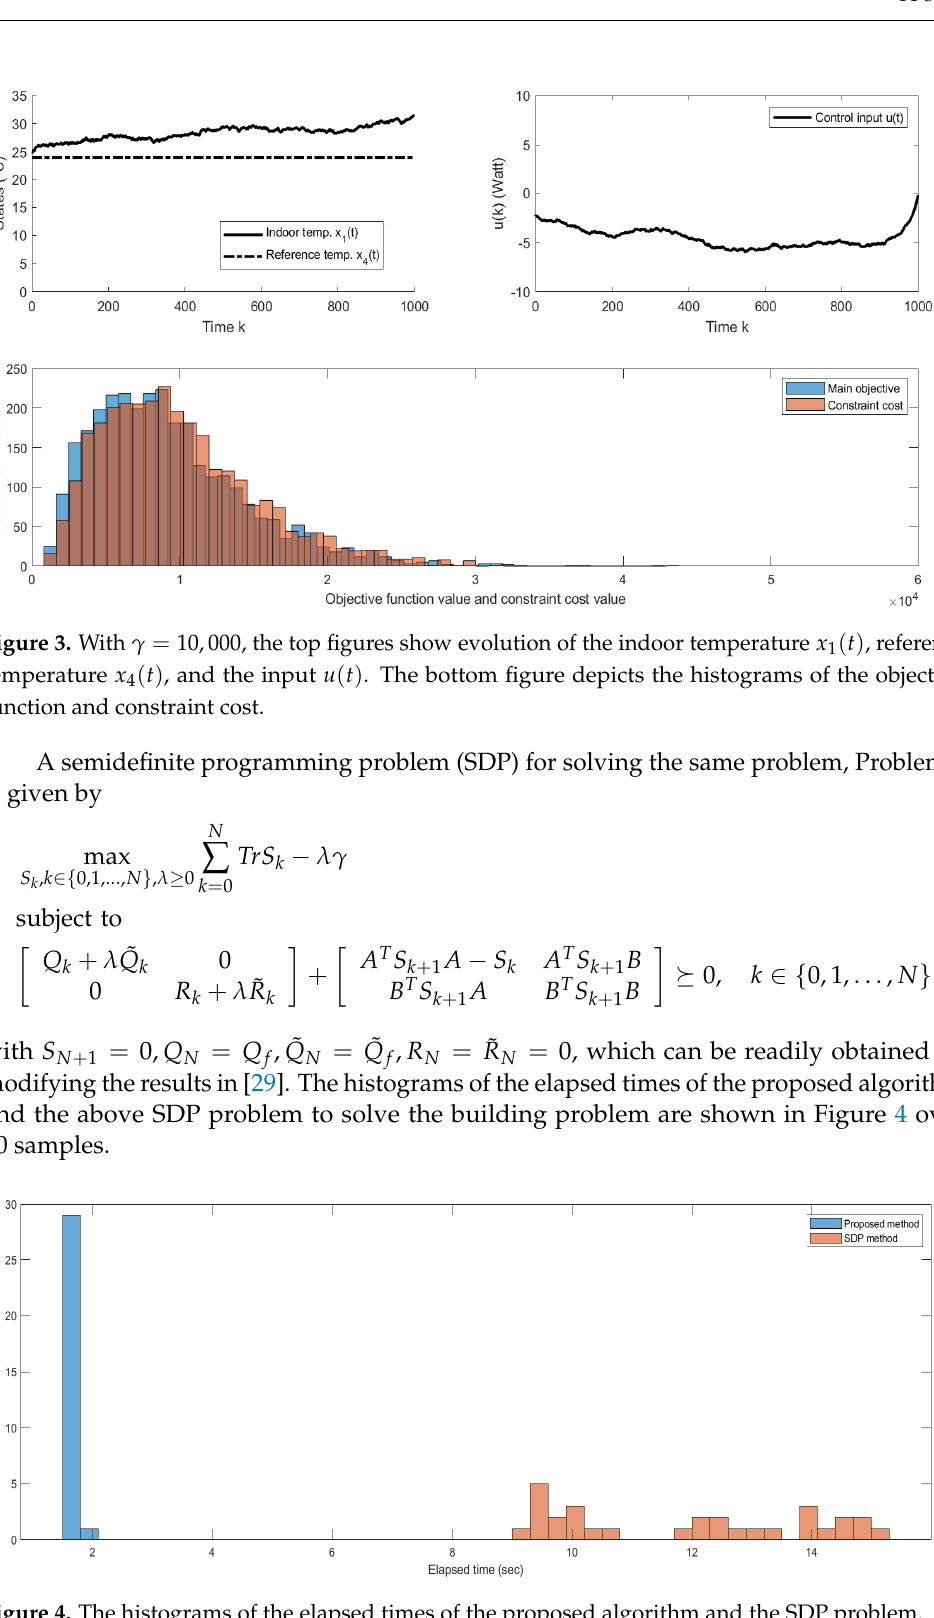
Figure 4. The histograms of the elapsed times of the proposed algorithm and the SDP problem. The average elapsed times are 1.7551 s and 11.8987 s for the proposed method and the SDP problem, respectively. The result demonstrates that the proposed algorithm is computationally more efficient than the SDP